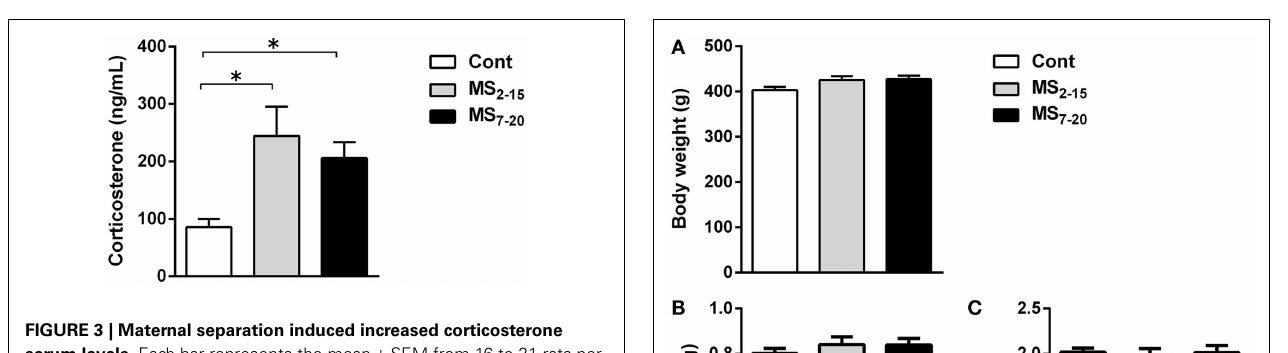
FIGURE 3 | Maternal separation induced increased corticosterone serum levels . Each bar represents the mean + SEM from 16 to 21 rats per group from two independent experiments.